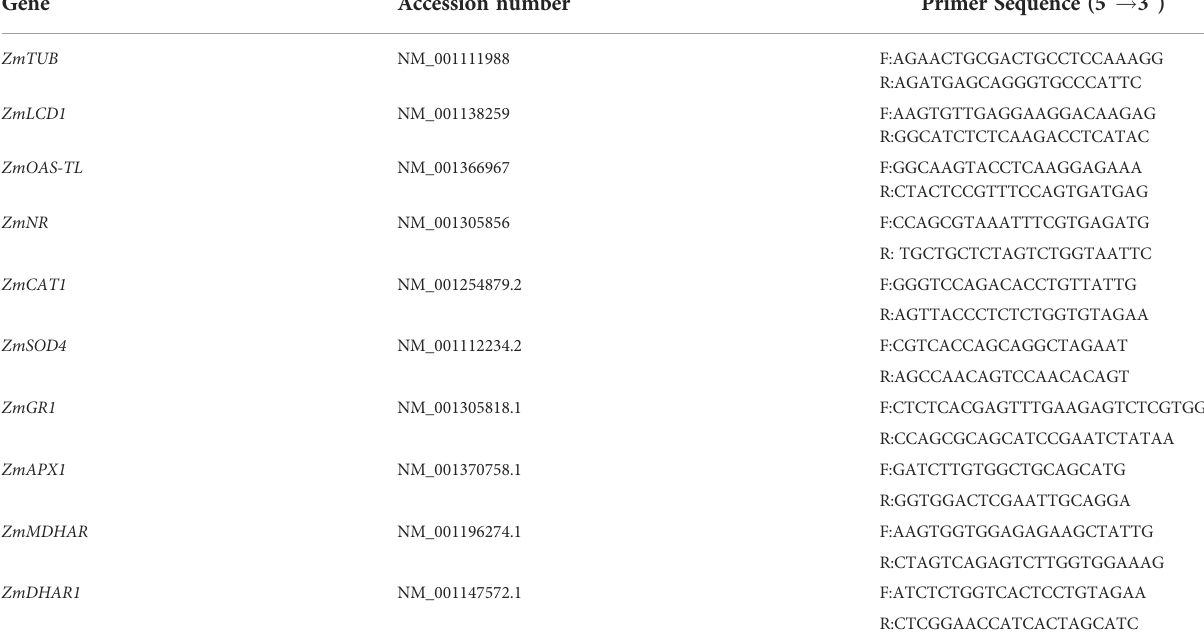
TABLE 1 Genes and primer information was used in this